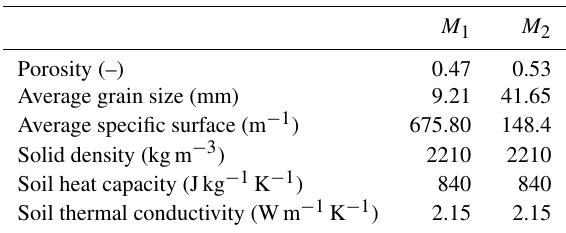
Table 1. Properties of the porous